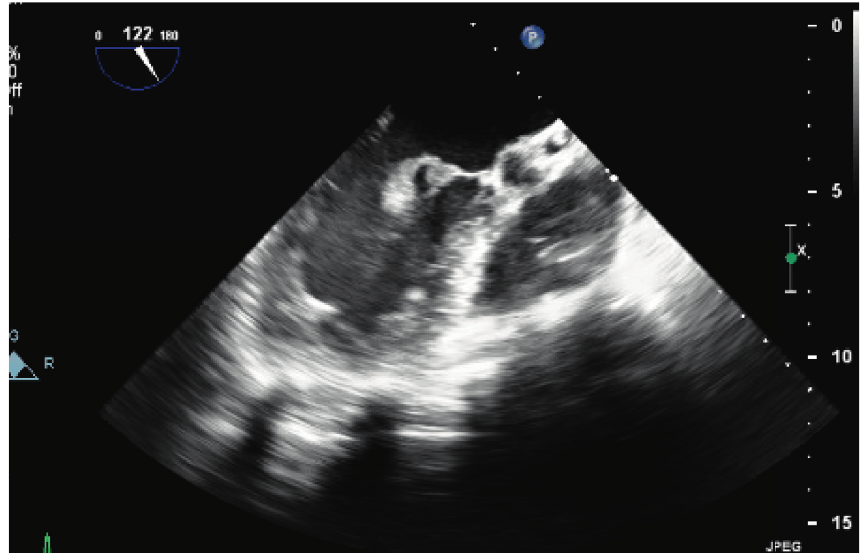
Figure 5: Echo view showing pedunculated left atrial mass.